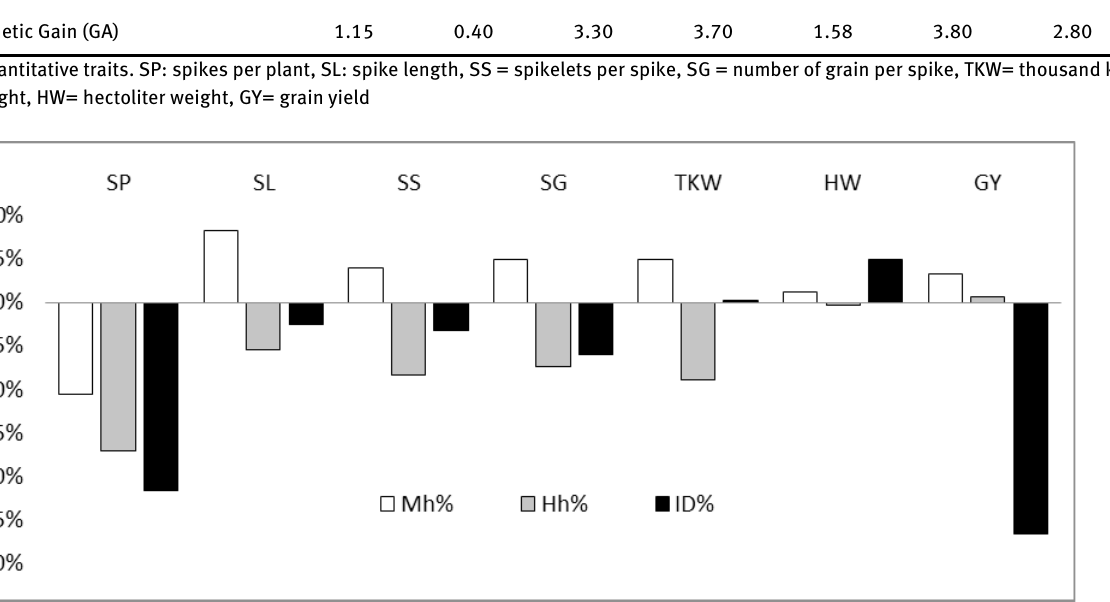
Figure 1: Percentage of relative heterosis (Mh%), heterobeltiosis (Hh%) and inbreeding depression (ID%) from CIMMYT 820 x Don Santiago INTA triticale cross. Traits: SP: spikes per plant, SL: spike length, SS: spikelets per spike, SG: number of grains per spike, TKW: thousand kernel weight, HW: hectoliter weight, GY: grain